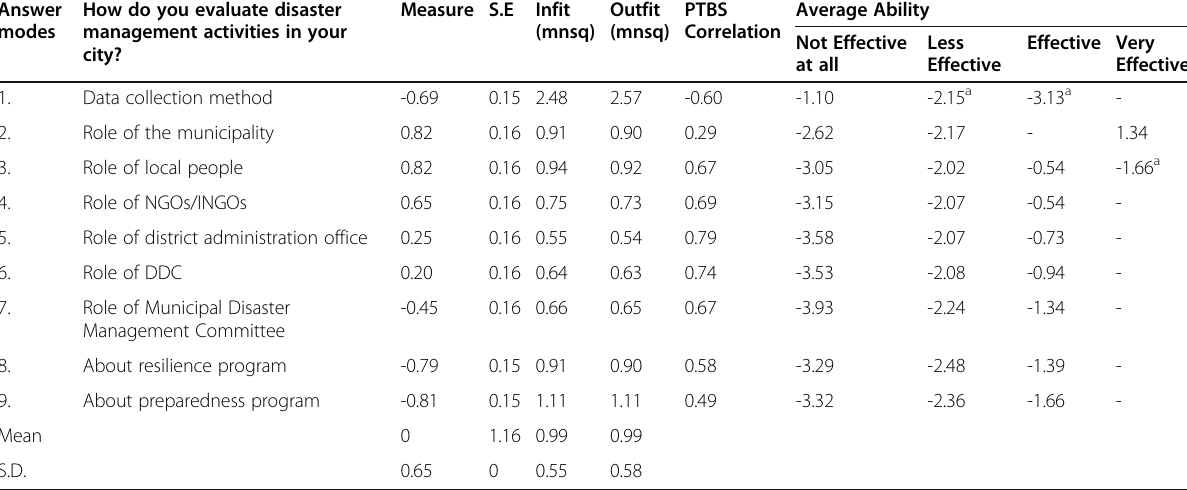
Table 8 Partial Credit Model on perception of disaster risk scale measurements through a question related to disaster management activities in the Pokhara city Answer